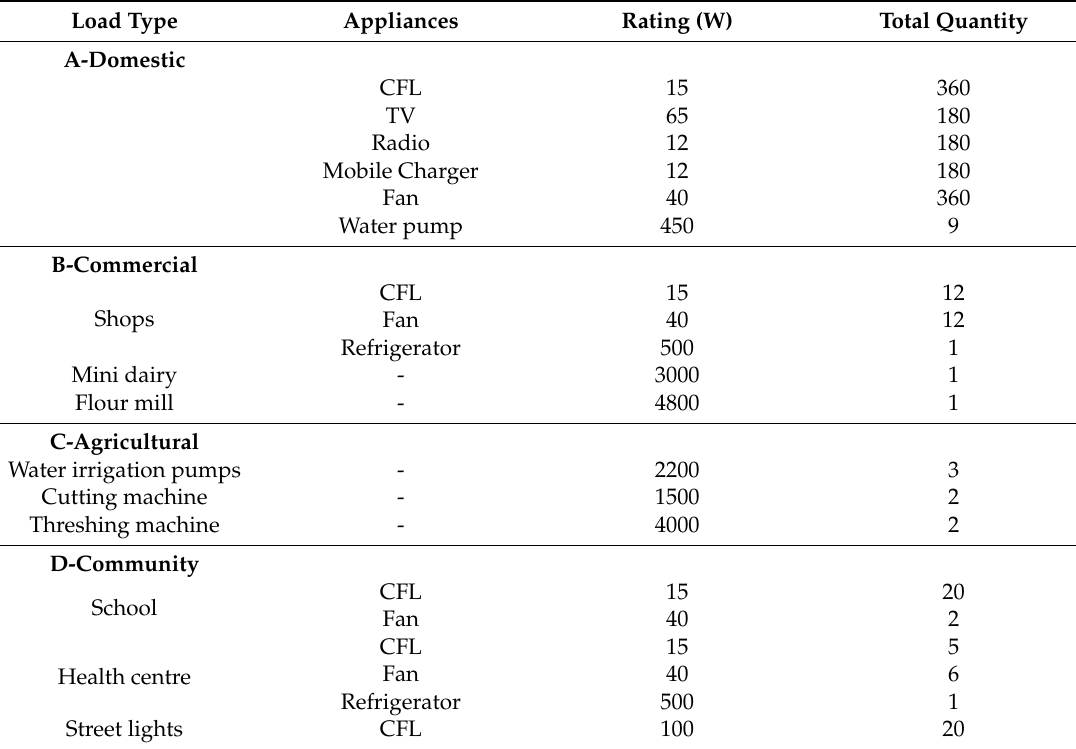
Figure 4. The seasonal load profile of the study location. Table 3. Appliances’ requirement and rating for different sectors of energy consumption .